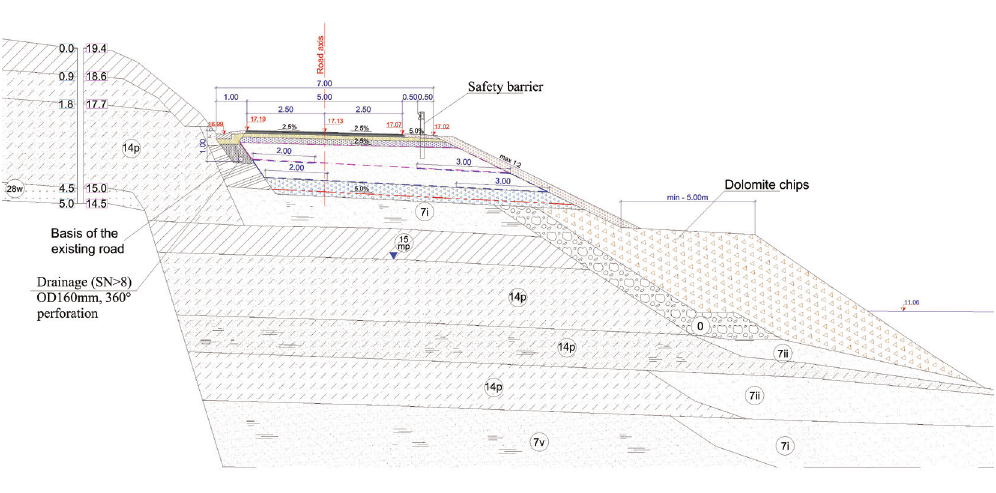
Figure 4. Project solution